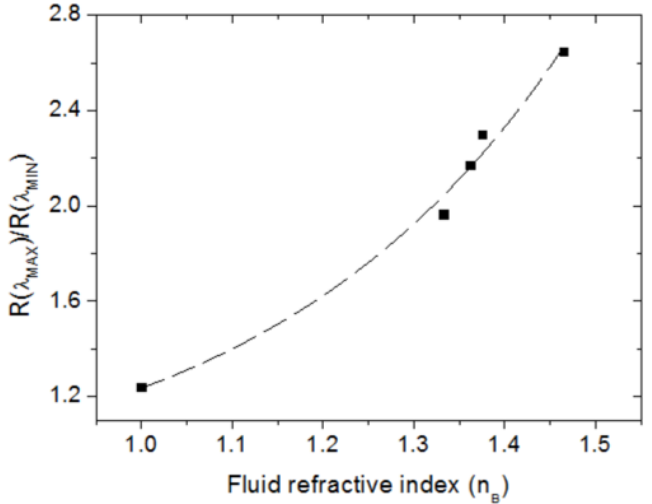
Figure 6. Normalized reflectance R(λ MAX )/R(λ MIN ) as a function of the fluid refractive index (n B ). Dashed line represents an exponential fit of the measured data points. Error bars are smaller than dots.